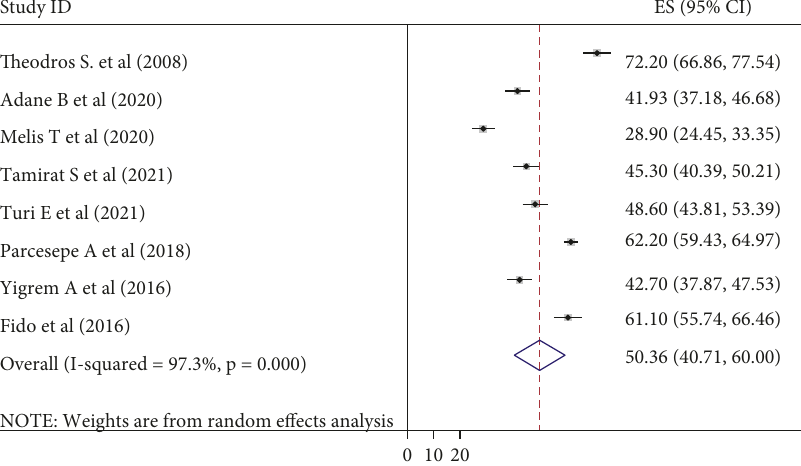
Figure 2: Pooled prevalence of perceived stigma among people living with HIV/AIDS and attending antiretroviral therapy in Ethiopia, 2021.